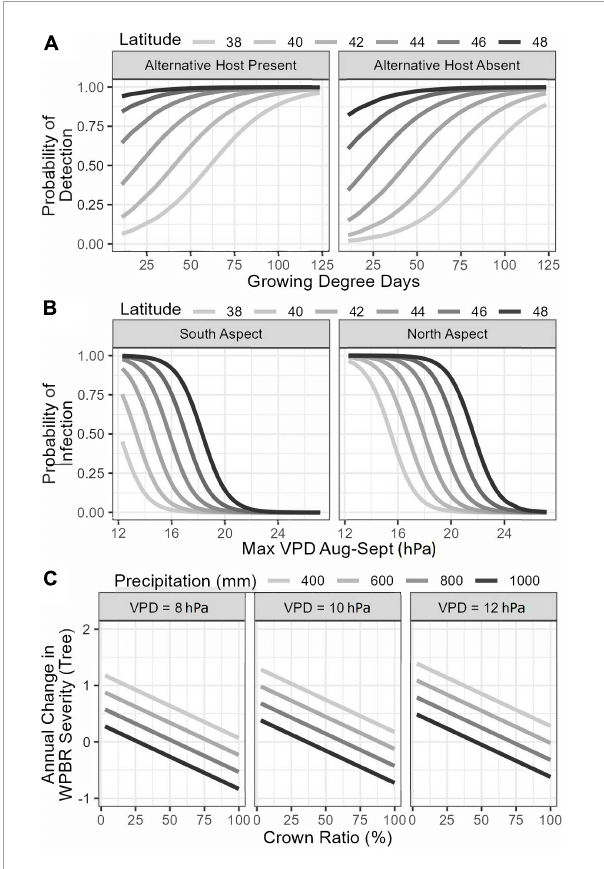
FIGURE6 Best subset logistic regression (A,B) and final general linear mixed effects (C) models predicting white pine blister rust presence in a stand (A) , tree infection probability (B) , and annual change in disease severity (C) based on stand, site, and meteorological